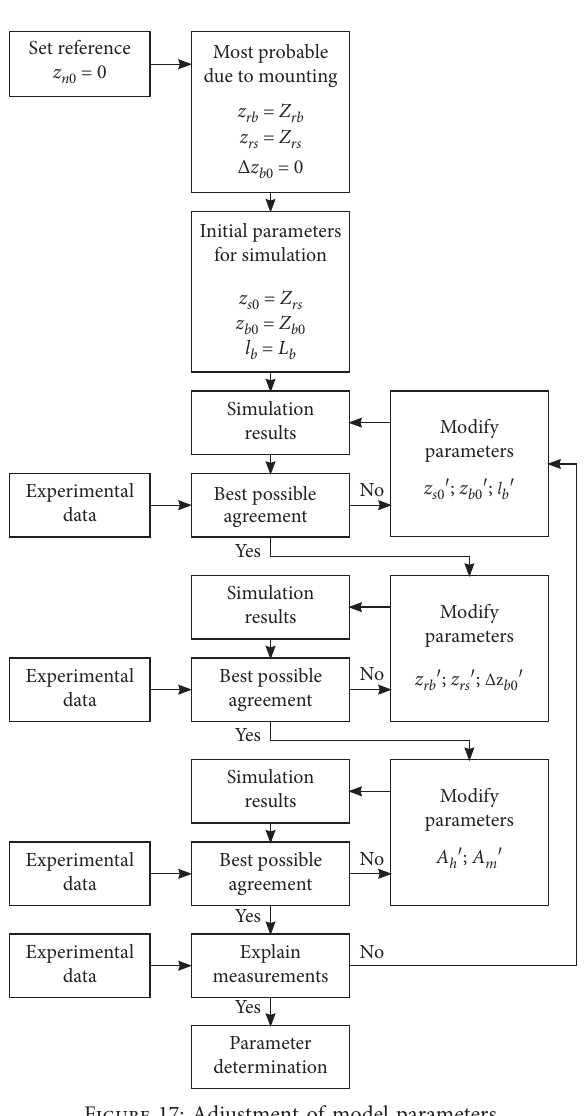
Figure 17: Adjustment of model parameters.